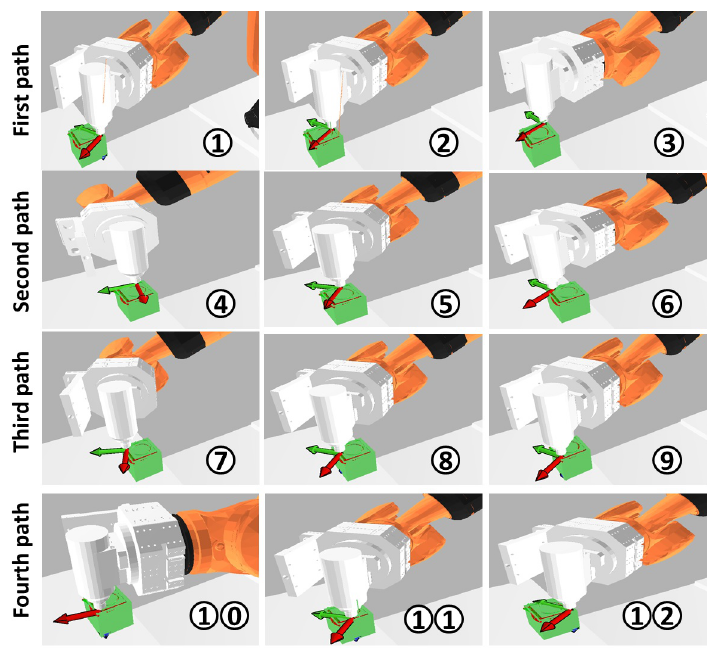
Figure 12. Sequence of robot movements for a four-edge machining task with stiffness optimization after planning with the T-RRT algorithm.